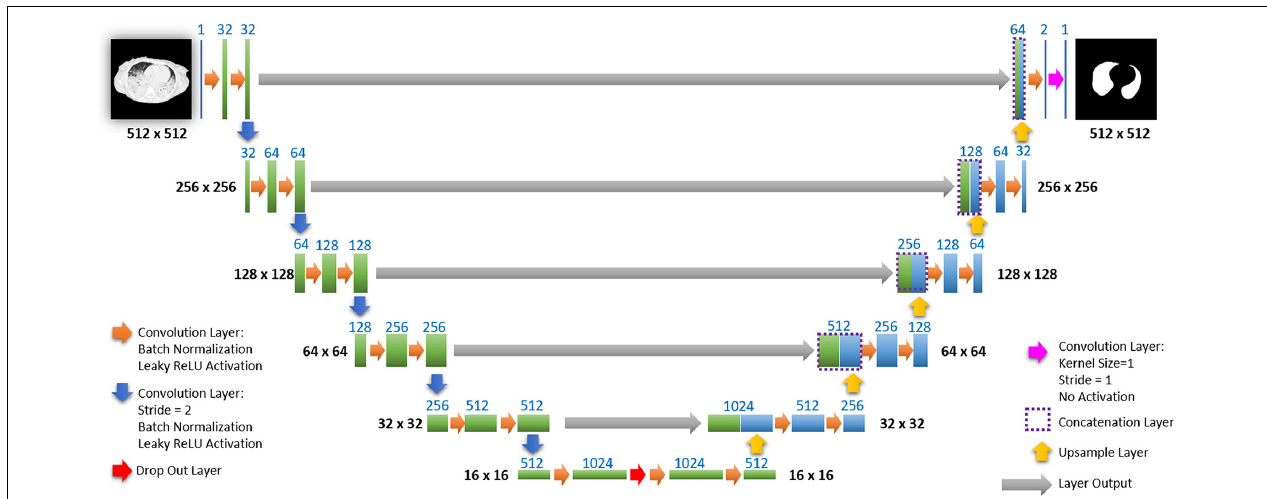
FIGURE 3 | Our used U-Net architecture. Each green or blue box corresponds to a multi-channel feature map. The number of channels is shown above the box. The specifications 512 × 512 to 16 × 16 (in the lowest resolution) show the x , y dimensions in pixels of the input and output images (or feature maps).